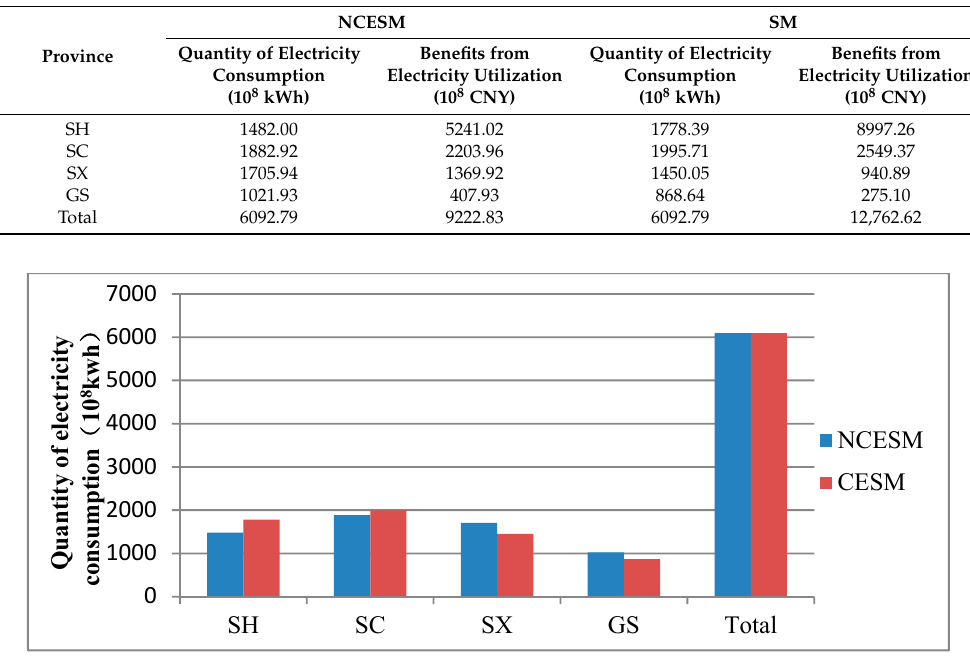
Figure 1. Comparison of quantity of electricity consumption under the two models.